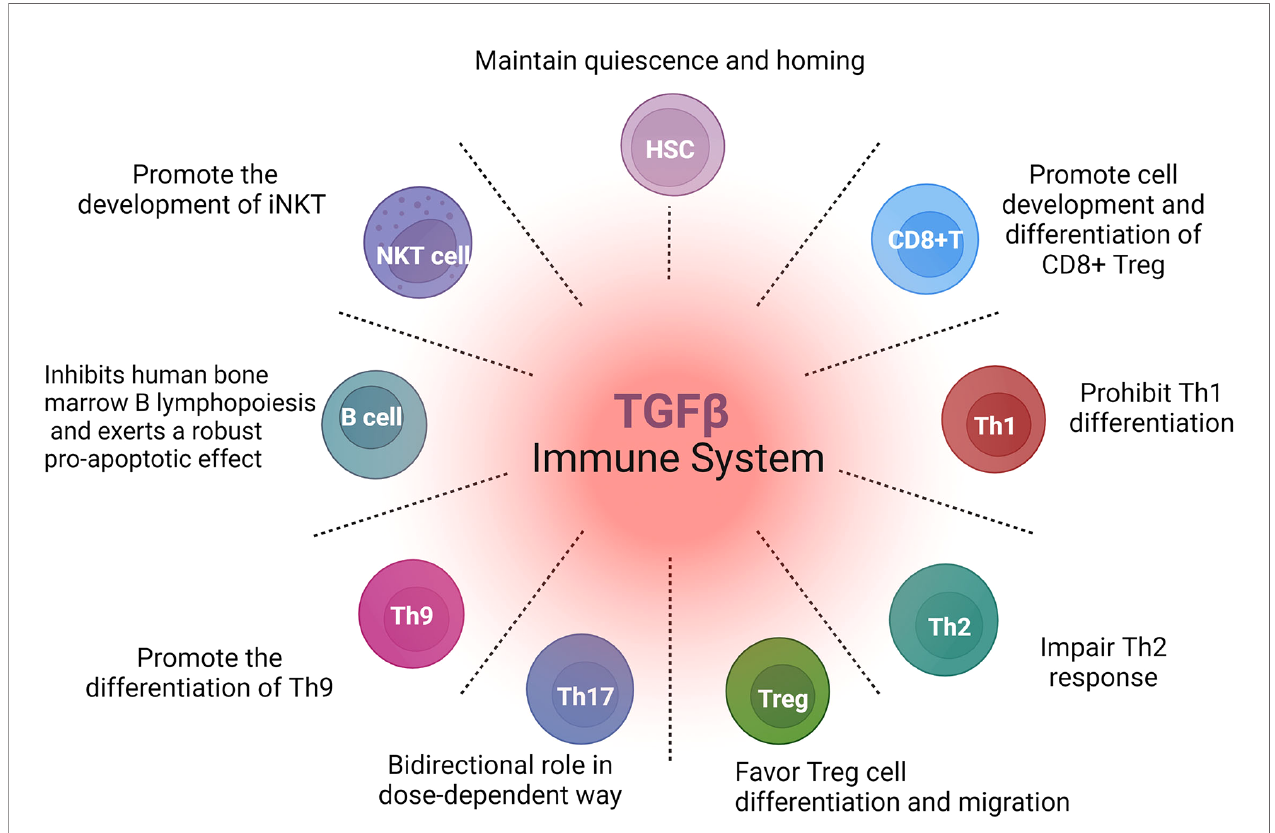
FIGURE 2 | Schematic overview of the multiple effects of TGF- b on immune cells. TGF- b signaling broadly regulates the development of immune cells from the embryo to the adult. TGF- b exerts cell-speci fi c functions in multiple immune cell components during development via different molecular